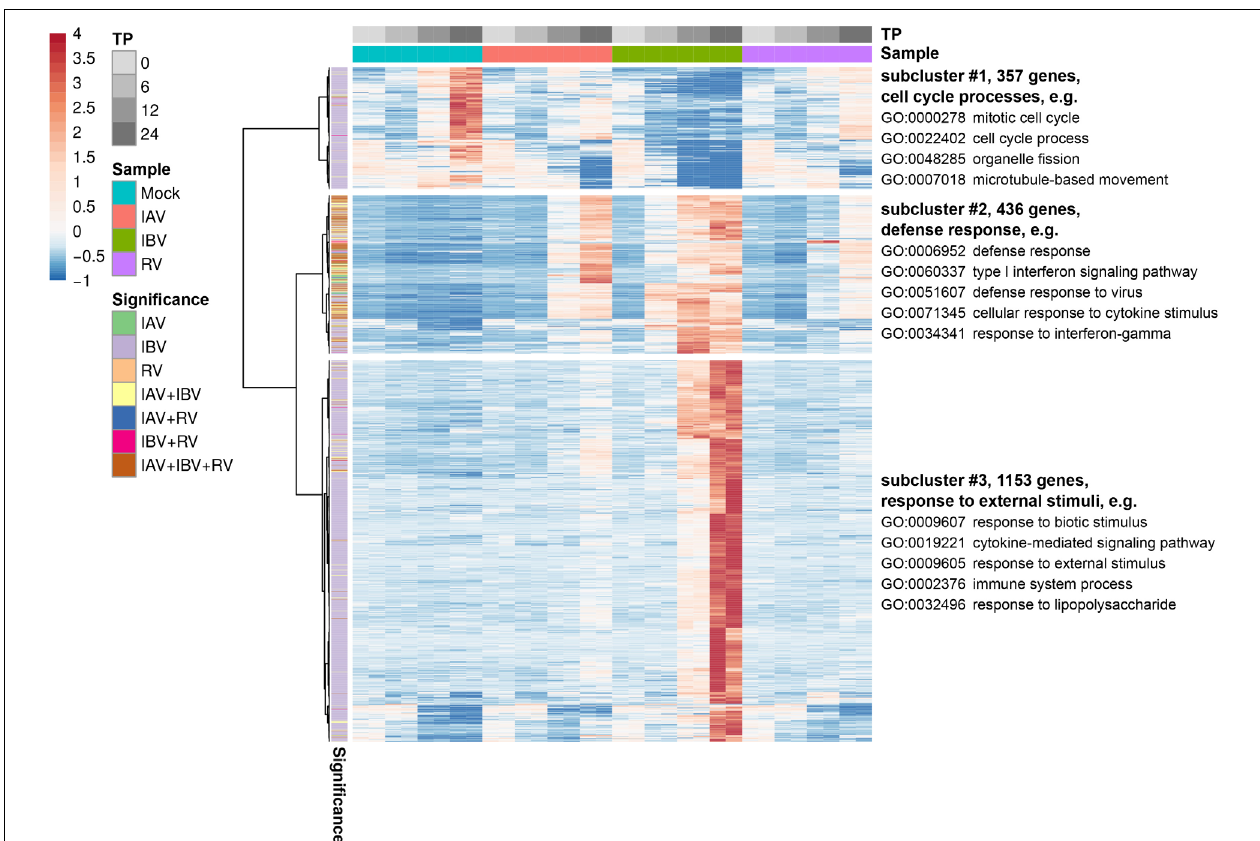
FIGURE 4 | Heatmap for differentially expressed genes with an absolute log2 fold change ≥ 2 across all virus infections. Three subclusters as determined by hierarchical clustering are shown and GSEA was performed for each individual sub-cluster and the major significantly enriched pathways are